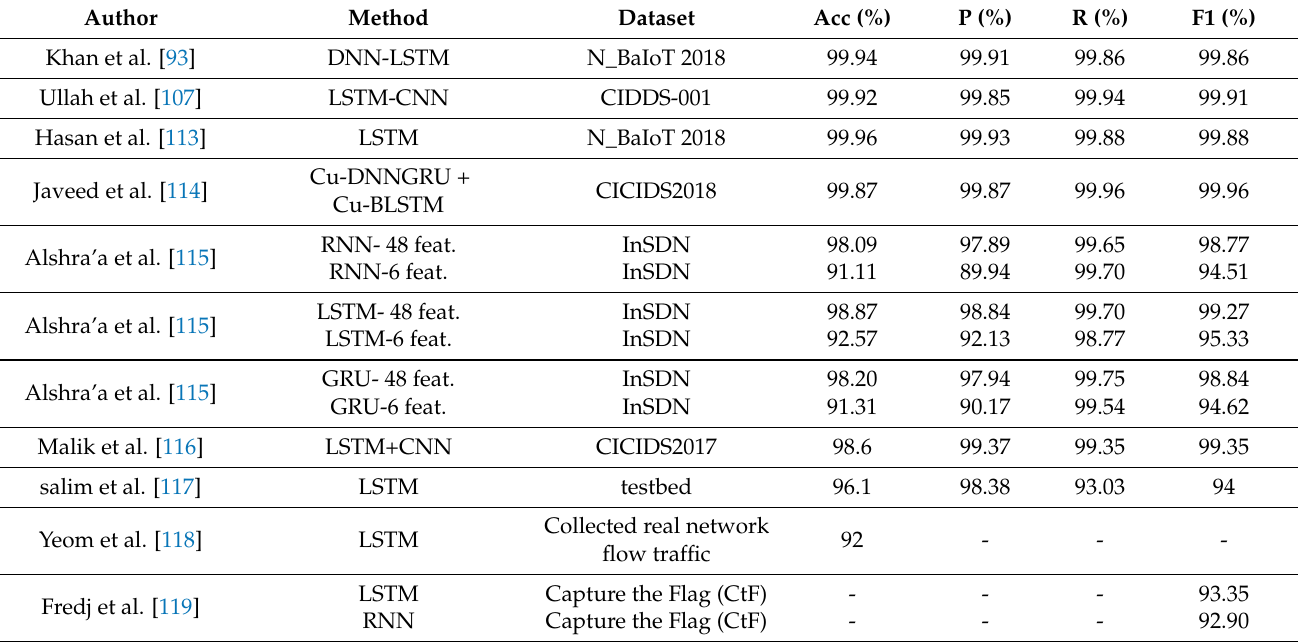
Table 7. Summary of BotNet attack Detection using RNN, LSTM and GRU in an SDN-enabled IoT Networks.